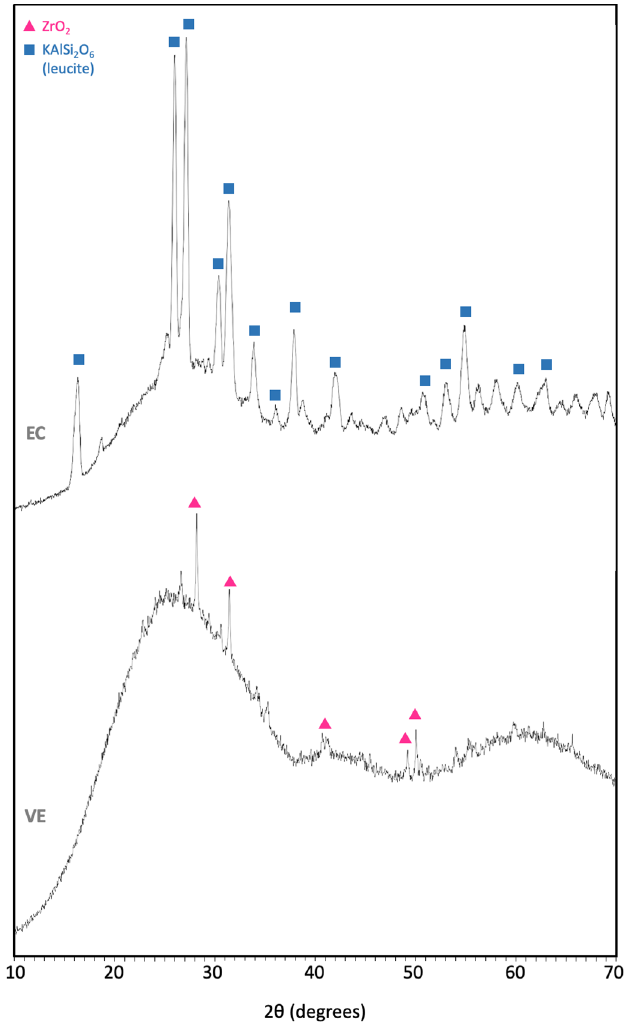
Figure 3. X-Ray fluorescence (XRF) patterns of the crystalline phases of EC and VE.